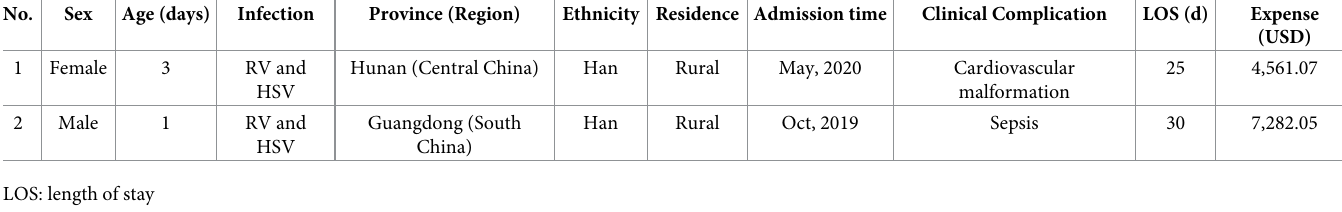
Table 5. The general sociodemographic characteristics and disease burden of pediatric patients with a mixed infection during hospitalization from December 2015 to December 2020.